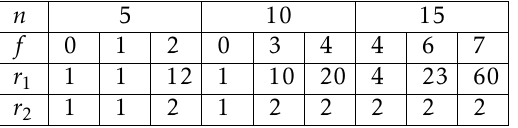
Table 6. Performance Comparison for n = 5 , 10 , 15